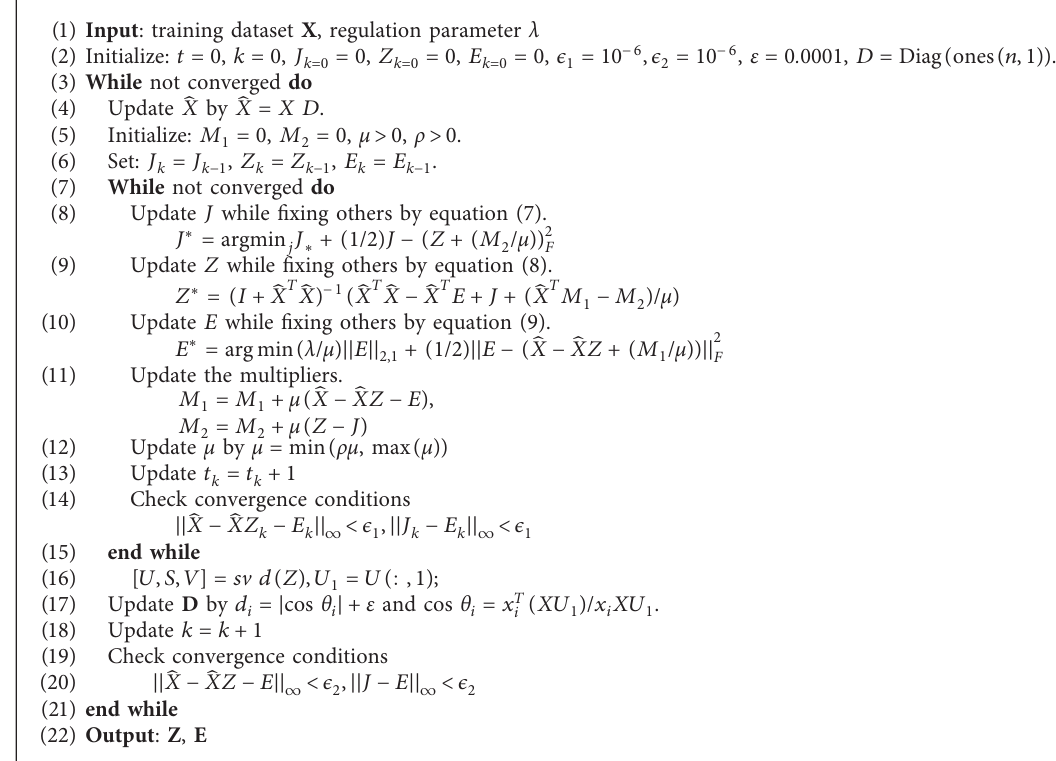
A LGORITHM 1 : Algorithm of our proposed